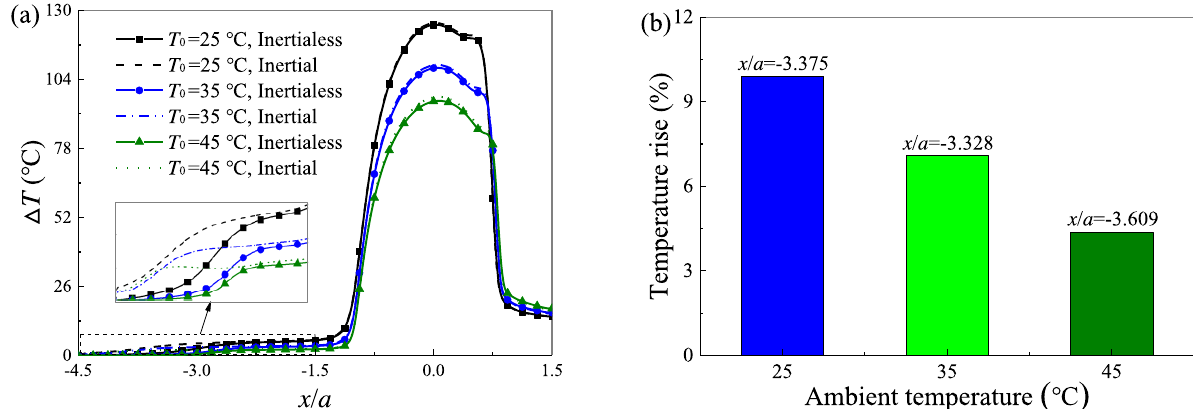
Fig. 19. Temperature rise with inertia force at varied ambient temperature ( y =0): (a) temperature rise, and (b) maximum relative percentage of temperature rise